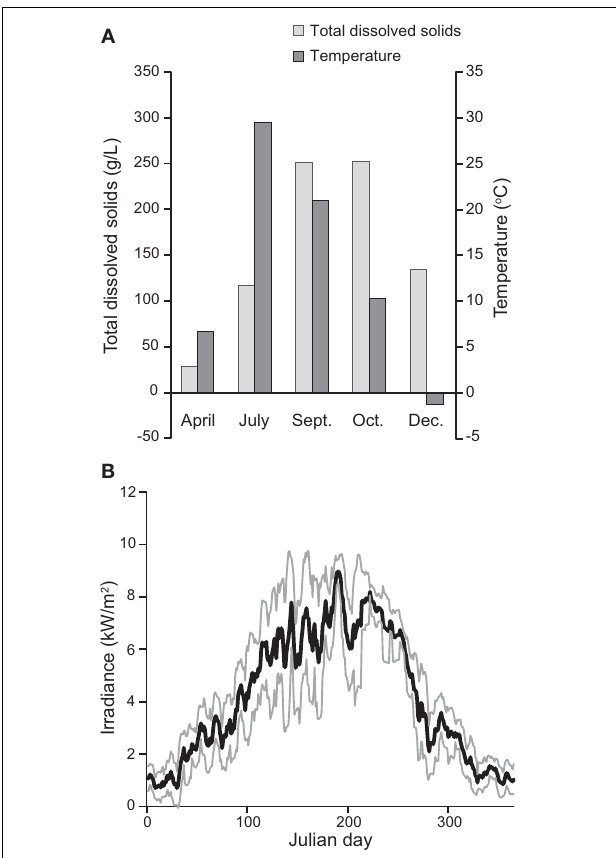
FIGURE 2 | Seasonal variation in the environmental conditions experienced by the mat community in Hot Lake. (A) Variation in salinity (as represented by total dissolved solids) and temperature in water proximal to sampled mat. December values are from water immediately below ice cover. (B) Variation in irradiance throughout 2011 as recorded by remote automated weather station OVLW1. Maximal recorded daily irradiance near Hot Lake was 9574 W/m 2 on June 26, while just 160 W/m 2 was recorded at minimum on January